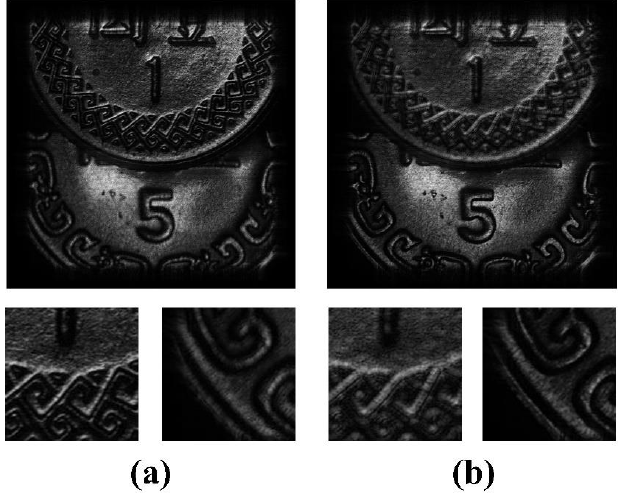
z  115mm z  Figure 3. Reconstructed image at ( a ) 90mm r r Figure 3. Reconstructed image at ( a ) z r = 90mm, and ( b ) z r = 115mm. The larger figures show the whole field of view, while the small figures are the zoom-in of selected regions (Reproduced with permission from [57], OSA publishing,